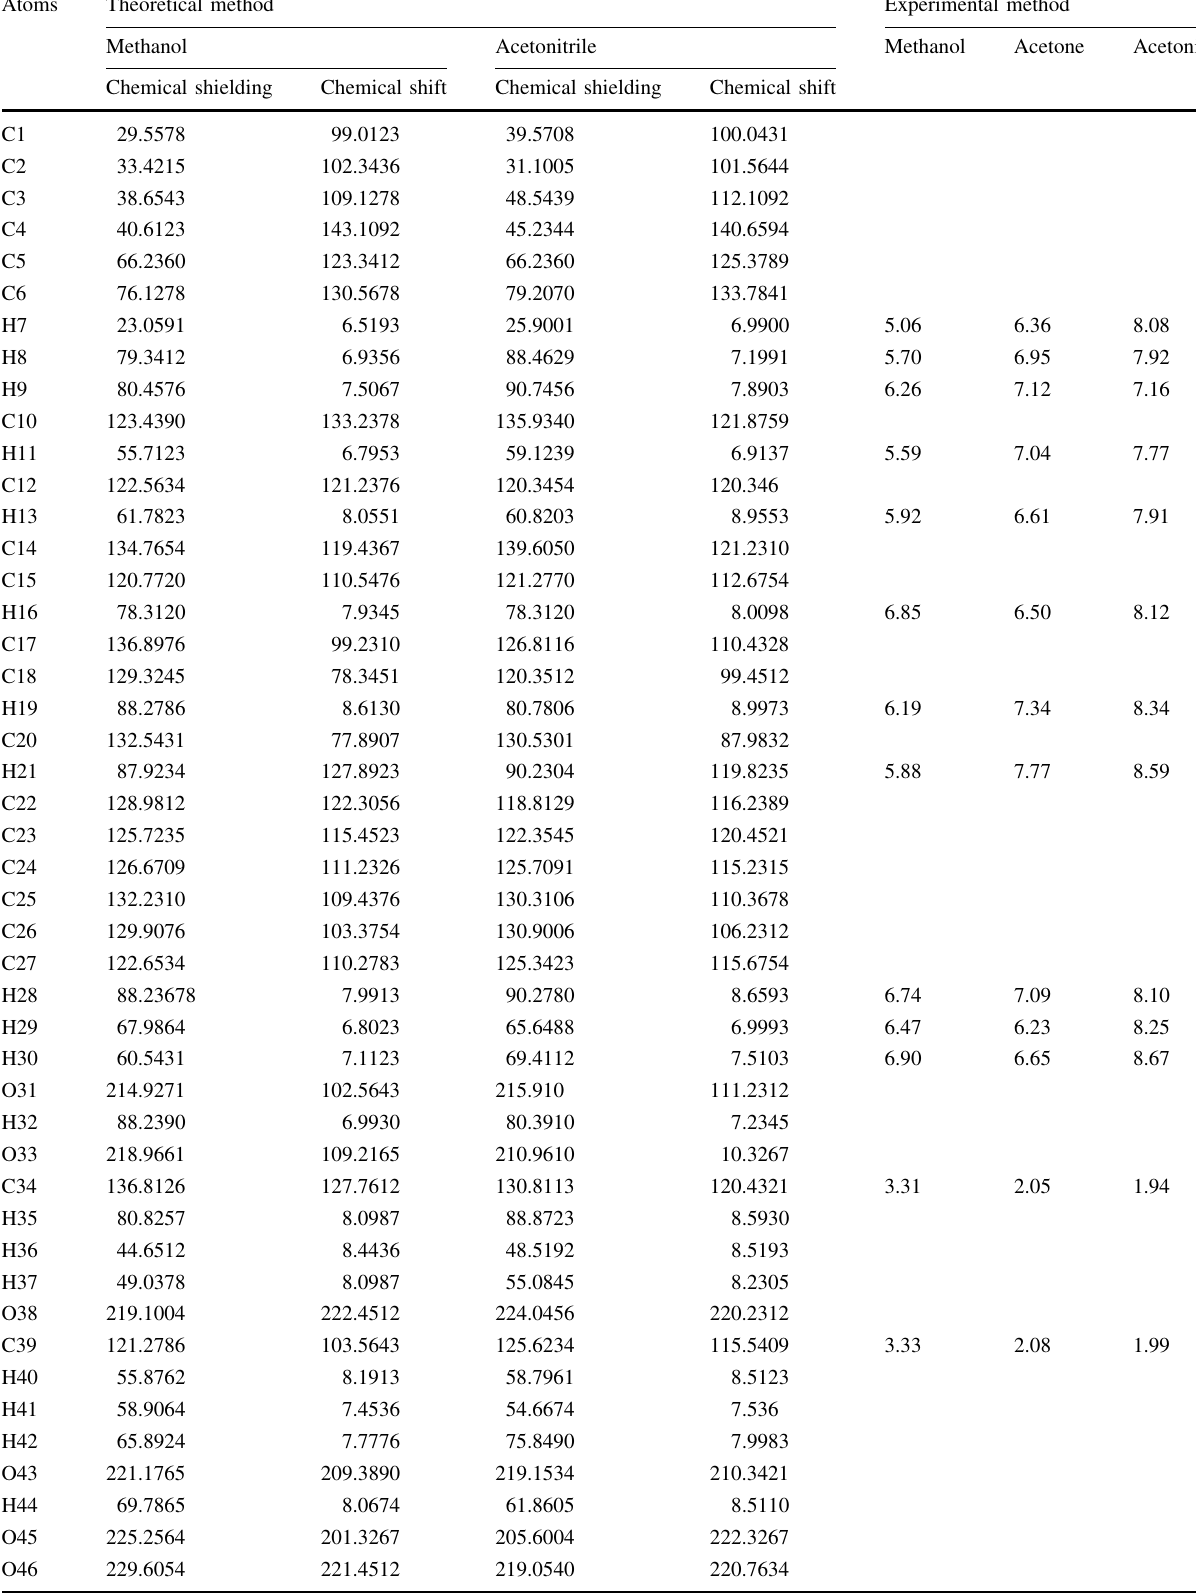
Table 4 The calculated 1 H, 11 C and 17 O NMR isotropic chemical shifts (all values in ppm) for curcumin using GIAO